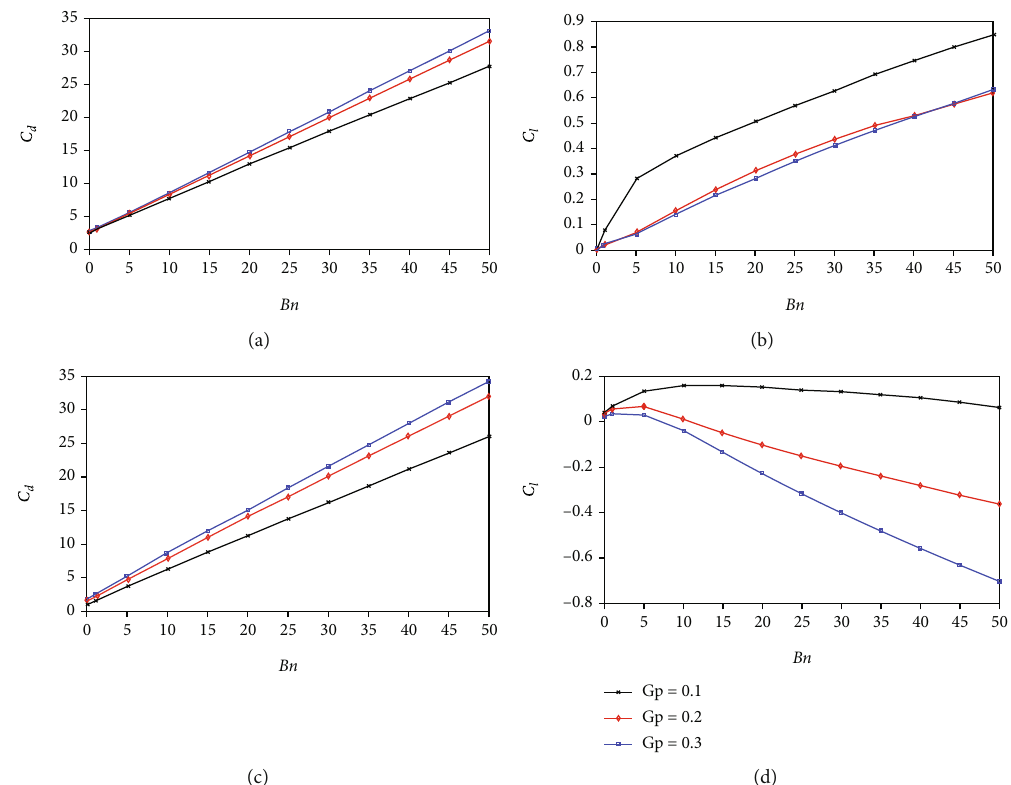
Figure 14: In fl uence of Bn and separation distance on drag and lift coe ffi cient. (a) Drag for left cylinder. (b) Lift for left cylinder. (c) Drag for right cylinder. (d) Lift for right